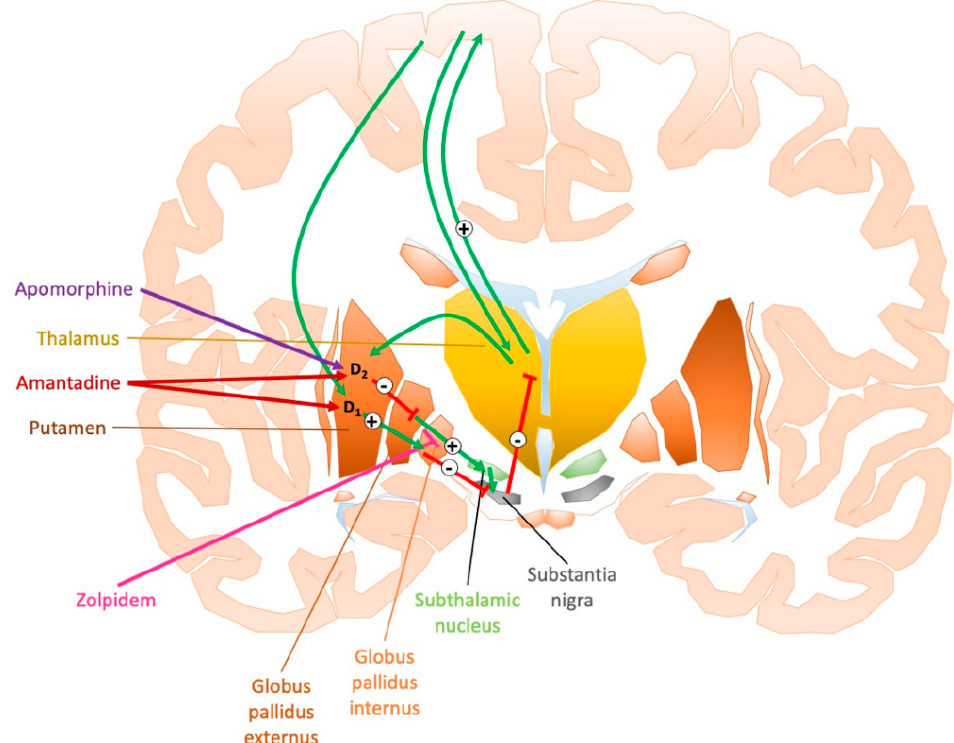
Figure 3. Diagram of the cortico-striatal-thalamic-cortical loop and potential impacts of apomorphine, amantadine, and zolpidem on spontaneous awakenings. There are two dopaminergic pathways in this loop, the direct pathway and the indirect pathway. The direct pathway expresses excitatory dopamine receptor 1 (D 1 ), and striatal neurons project to the globus pallidus internus and then to the substantia nigra pars reticulata, which then inhibits the thalamus through GABAergic projections. The indirect pathway expresses the inhibitory dopamine receptor 2 (D 2 ), and these striatal neurons project to the globus pallidus externus and then to the subthalamic nucleus. Glutamatergic neurons from the subthalamic nucleus project to the substantia nigra, which then inhibits the thalamus via GABAergic projections [88]. Amantadine is an indirect dopamine agonist and may contribute to both the direct and indirect pathways [48]. Apomorphine is a dopamine agonist with a high affinity for D2 receptors, feeding into the indirect pathway [54]. Zolpidem is a GABA agonist and may inhibit the GABAergic projections reducing inhibitory tone to hypoactive areas of the brain and enhancing thalamocortical pathways [57,60], Dopamine Receptor 1 (D 1 ) and Dopamine Receptor 2 (D 2